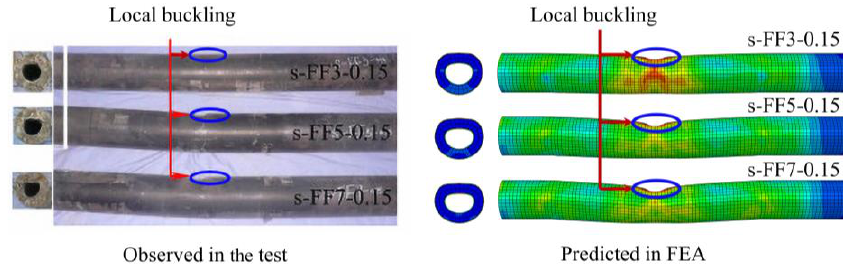
Figure 5. The damage pattern.